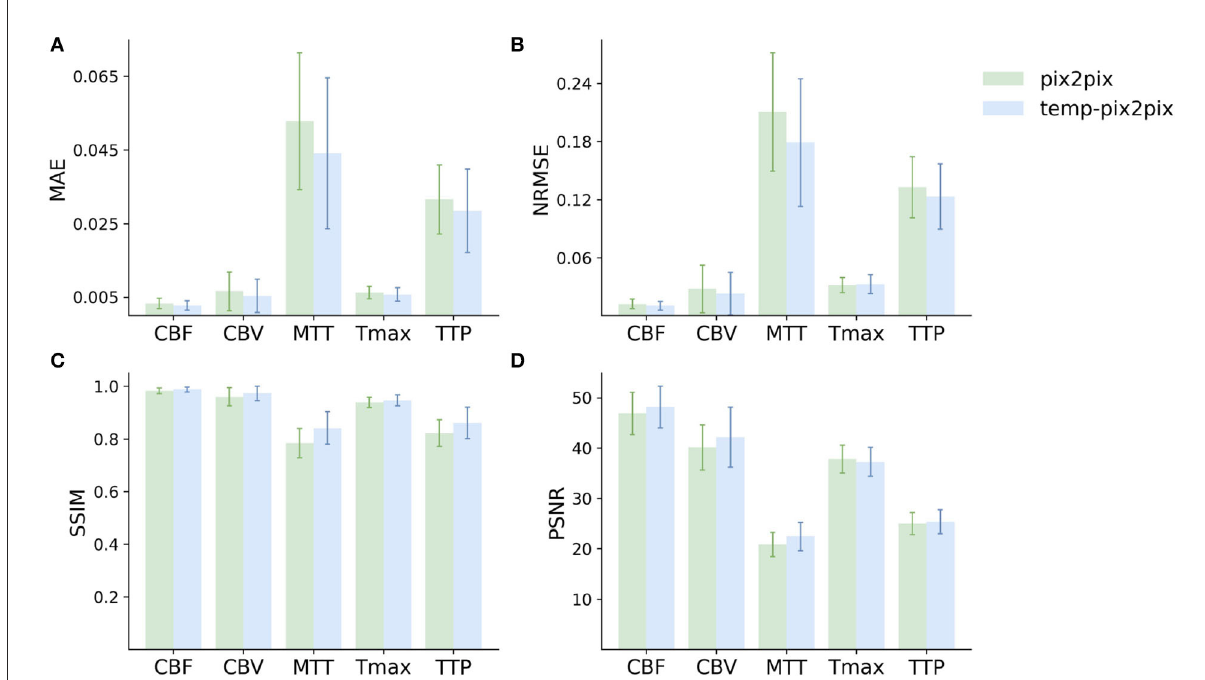
FIGURE7 Mean performance metrics for evaluating the similarity between the ground truth and the synthesized parameter maps generated by the pix2pix GAN (green) and the temp-pxi2pix GAN (blue) on the PEGASUS dataset. (A, B) Show the mean absolute error (MAE) and normalized mean root squared error (NRMSE), respectively (the lower, the better). (C, D) Show the structural similarity index measure (SSIM) and the peak-signal-to-noise-ratio (PSNR) (the higher, the better). For most metrics and parameter maps, the temp-pix2pix architecture shows a better performance compared with the pix2pix GAN. In terms of the metrics, the generated MTT maps showed the worst performance. The error bar represents the standard